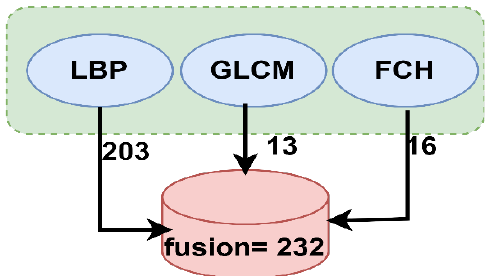
Figure 6. Fusion of features extracted by the LBP, GLCM, and FCH